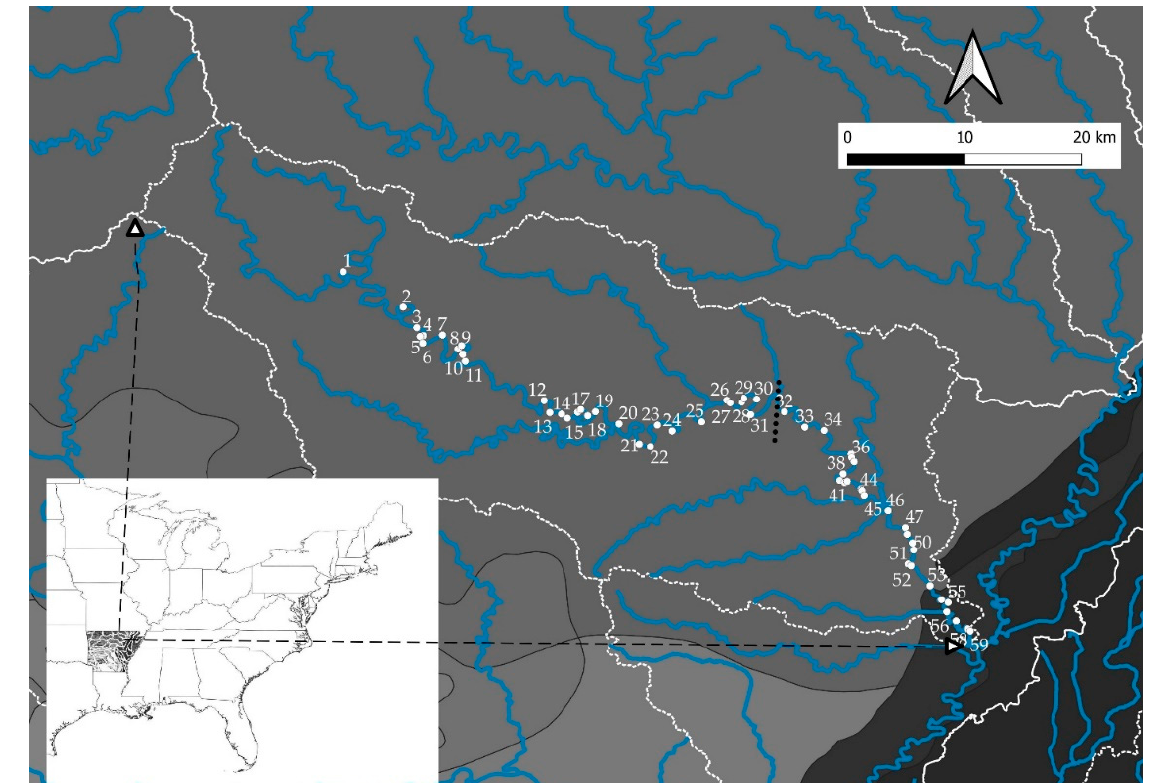
Figure 1. Map of the Strawberry River watershed, Arkansas, USA, sampling sites, and ecoregions. The inset map shows the location of the study area in the southcentral U.S.A. The blue lines are streams, the white dashed outline shows the watershed boundary, the shaded backgrounds with solid black lines are ecoregions (Ozark Highlands Central Plateau, gray shade; Mississippi Alluvial Plain, black), and white circles are the Strawberry River mussel sampling sites in numerical order upstream to downstream. Due to cartographic labeling issues, a few sites do not have labels. Black dotted line between sites 31 and 32 represents demarcation between the non-metric multi-dimensional scaling analysis upstream and downstream assemblage groupings.